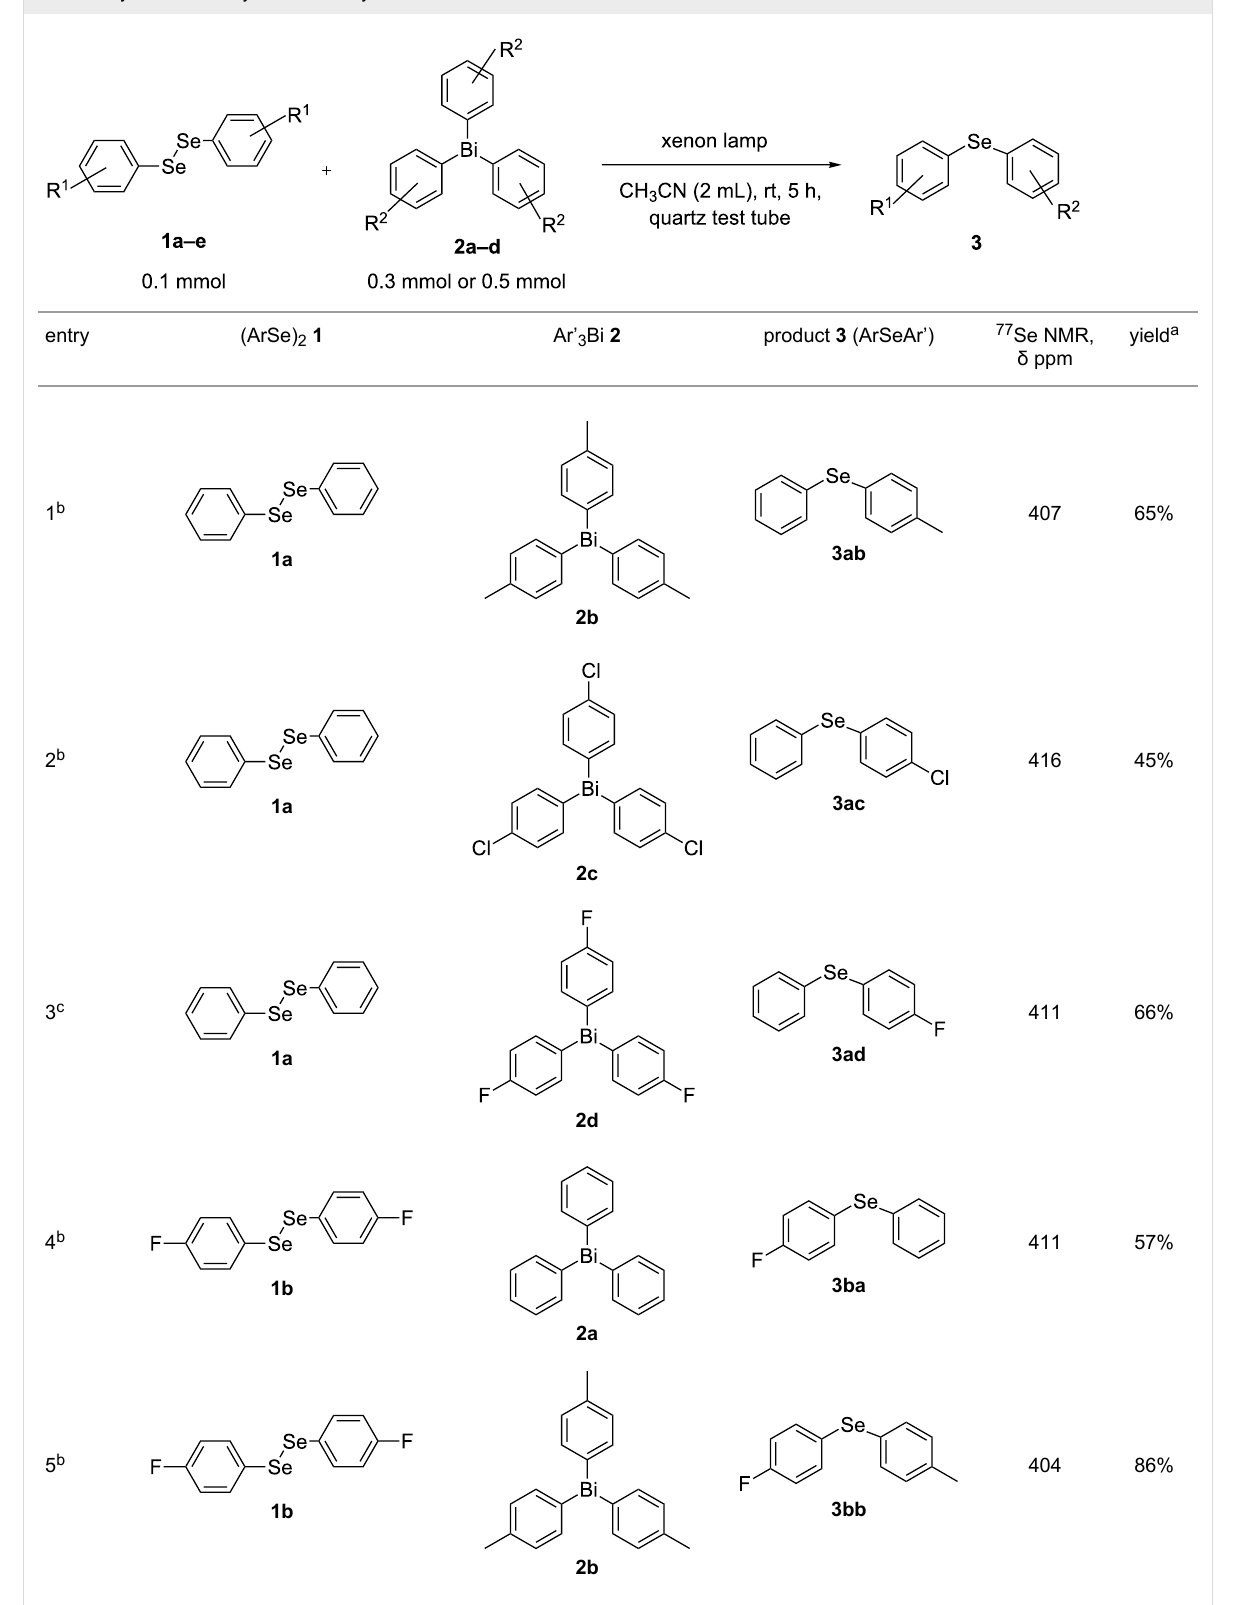
Table 2: Syntheses of unsymmetrical diaryl